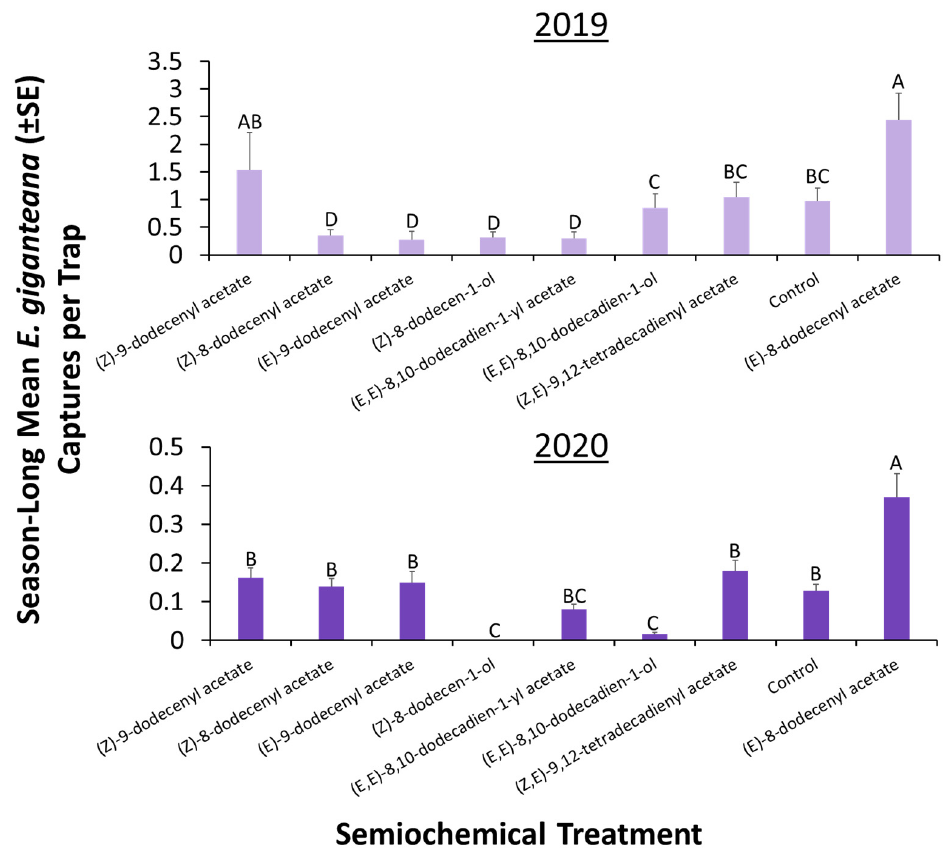
Figure 1. Season-long mean weekly trap capture ( ± SE) of E. giganteana on clear sticky cards deployed at 1-m height in row with Silphium integrifolium and baited with congeneric semiochemicals from related Eucosma spp. in Salina, KS, USA, at the Land Institute in from June to August 2019 (top panel) and 2020 (bottom panel). There was a total of n = 3 replicate fields used with 3 sets of replicate treatments at each field. Bars with shared letters are not significantly different from each other (Tukey HSD, α = 0.05). In both years, ( E )-8-dodecenyl acetate was a significant attractant to E. giganteana . In 2019, 3225 nontarget Lepidoptera were captured on the clear sticky traps. How- ever, the semiochemical lure paired with sticky cards did not significantly affect the num- ber of nontarget Lepidoptera (Repeated Measures LMM: χ 2 = 14.4; df = 8; p = 0.07). Each semiochemical treatment captured 6–14% of the total nontargets on the sticky cards over the course of the season, with a mean number of 4–9 nontarget Lepidoptera per card (Table